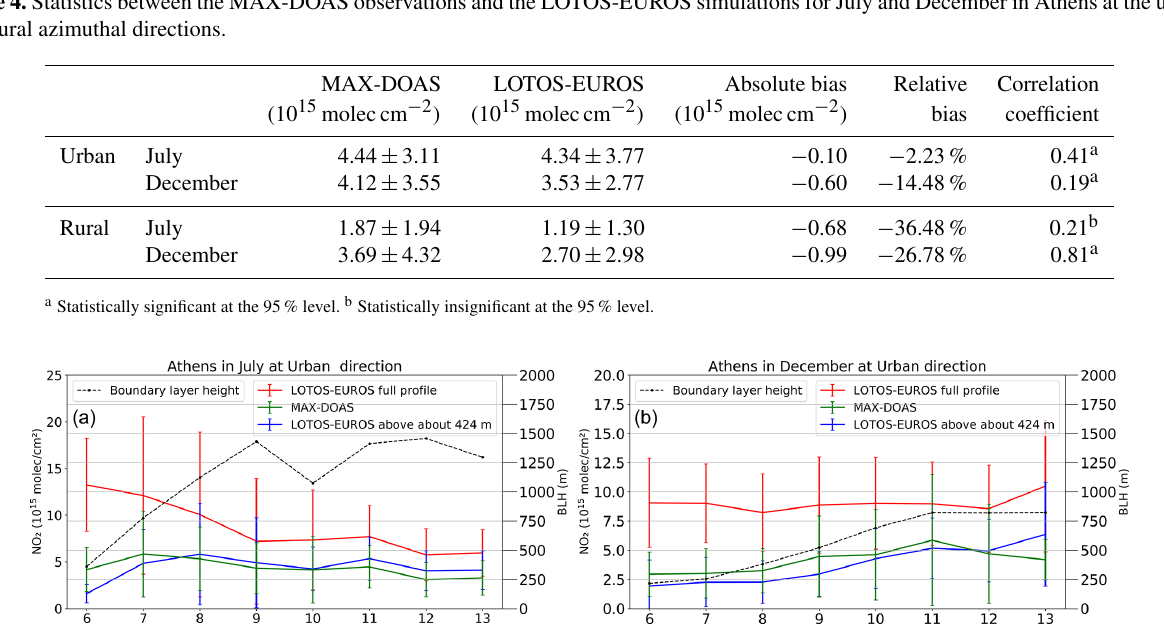
Figure 9. Average diurnal cycle of the MAX-DOAS in Athens (green line), LOTOS-EUROS full-profile (red line) NO 2 columns, LOTOS- EUROS partial NO 2 columns (blue line) and boundary layer height (black line) during July (a) and December (b) for urban direction. The error bars refer to the standard deviations of the averaged measurements and